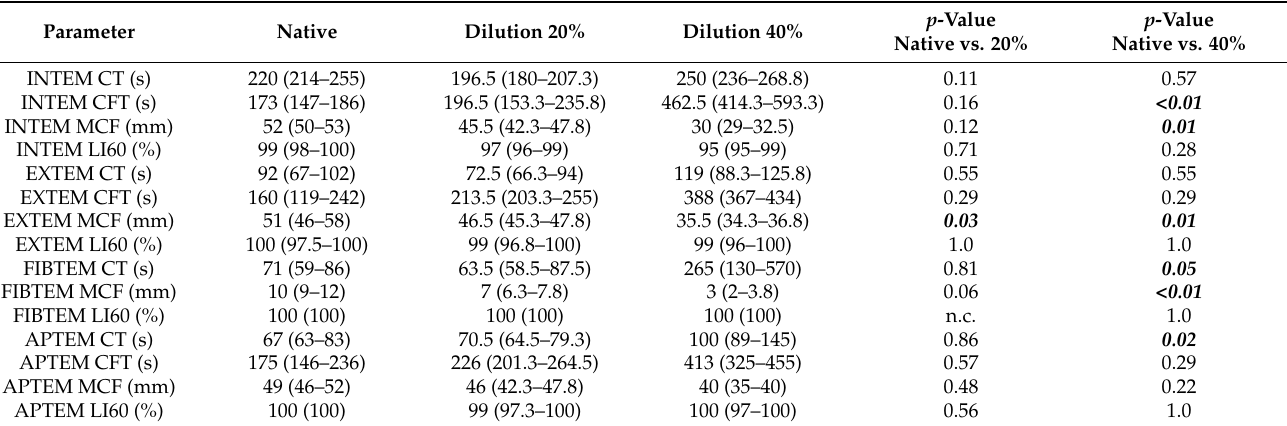
Table 1. Descriptive analysis of thrombelastography